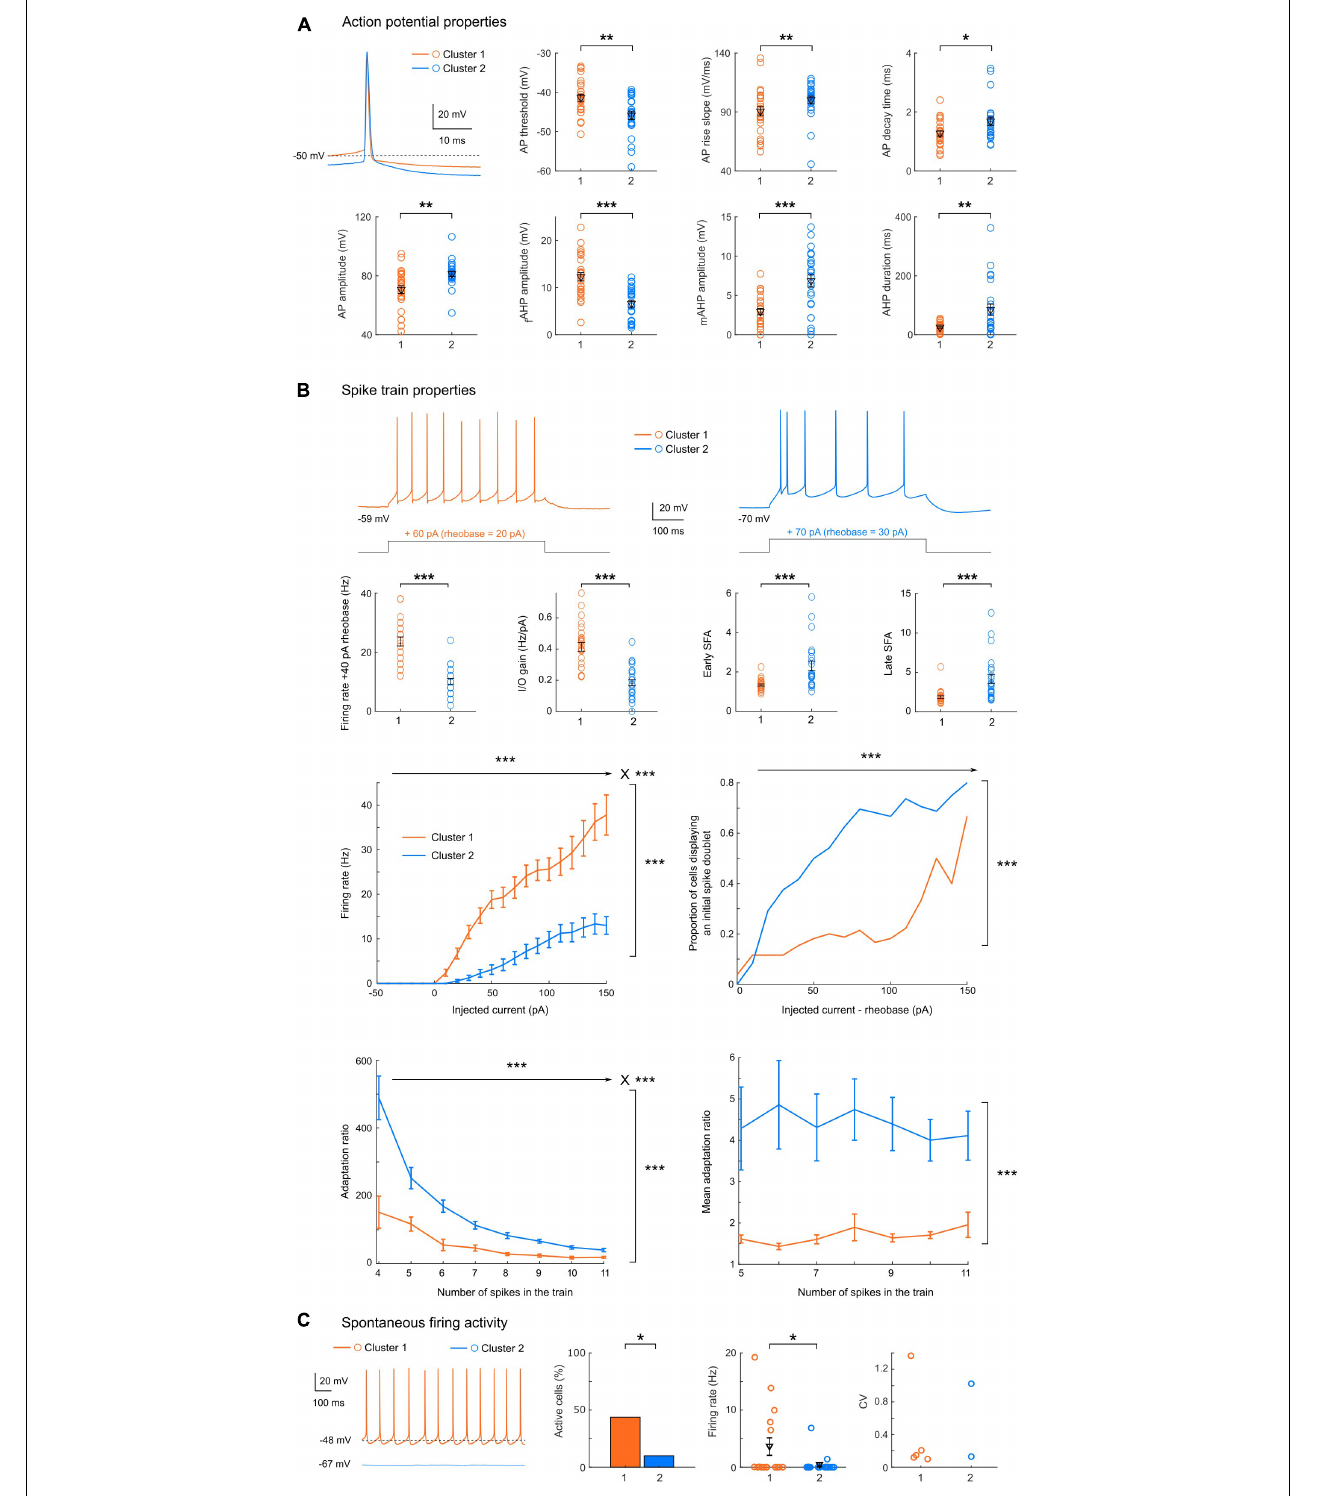
FIGURE 3 | Cluster 1 neurons have a higher excitability with less bursting and firing adaptation. (A) Representative action potentials for clusters 1 or 2, and scatter plots of the action potential properties showing significant differences between the two clusters, with mean and SEM indicated in black. Cluster 1 neurons have a more depolarized action potential threshold ( p = 0.0039), a smaller AP amplitude ( p = 0.0011), a slower rise slope ( p = 0.0090) but a shorter decay time